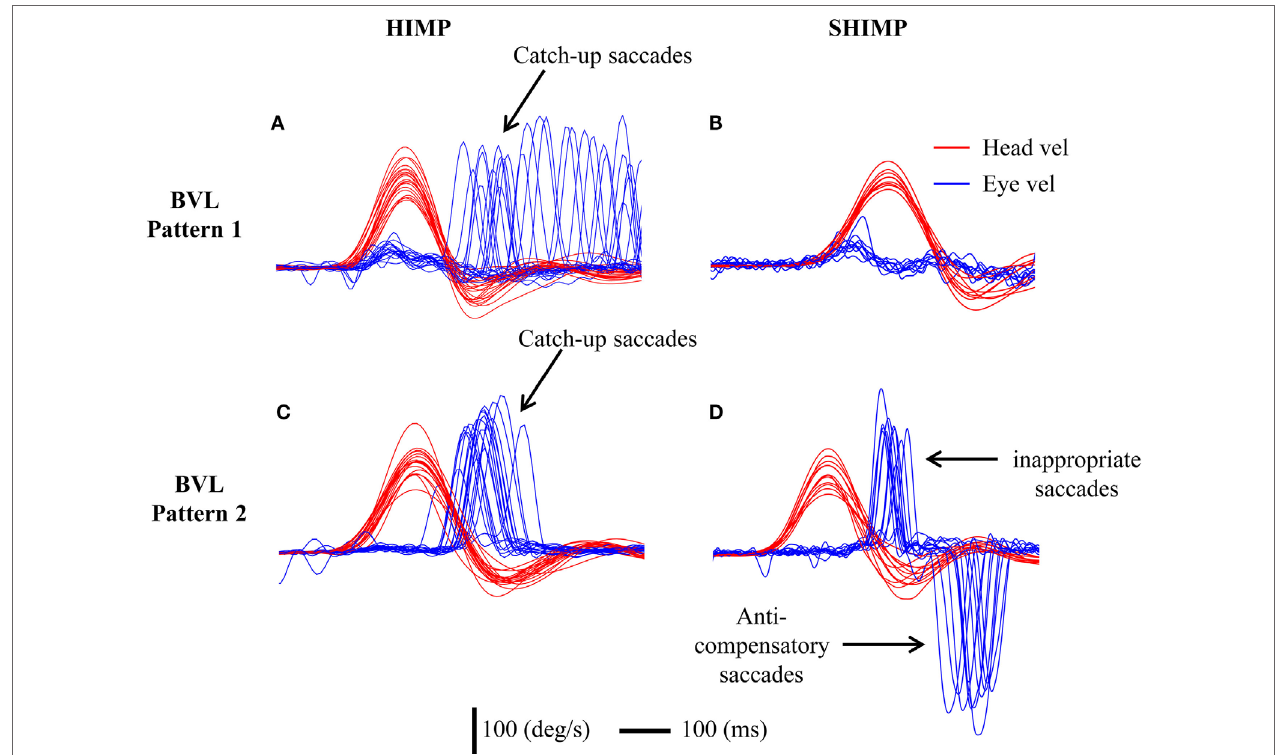
FigUre 3 | To show the different saccadic patterns in head impulse test (HIMP) and SHIMP procedures in two bilateral vestibular loss (BVL) patients. Eye velocity has been inverted to facilitate comparison with head velocity. Both patients show low vestibulo-ocular reflex (VOR) gains during head impulses. (a) A BVL patient with low VOR gain and mainly overt catch-up saccades in HIMPs who (B) did not perform any anti-compensatory saccades in SHIMPs. (c) A different BVL patient with low HIMP gain and clustered early overt catch-up saccades in HIMPs who (D) made covert saccades in SHIMPs followed by large anti-compensatory saccades on every trial because of the covert saccades in